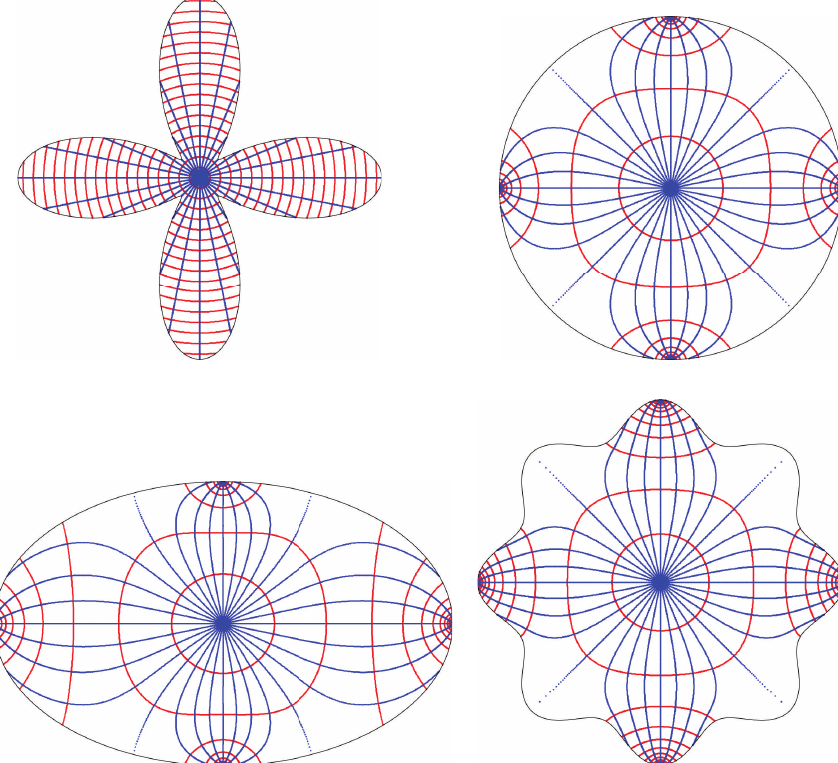
Figure 2: The conformal mappings from 𝐺 2 onto Ω 1 , Ω 2 , and Ω 3